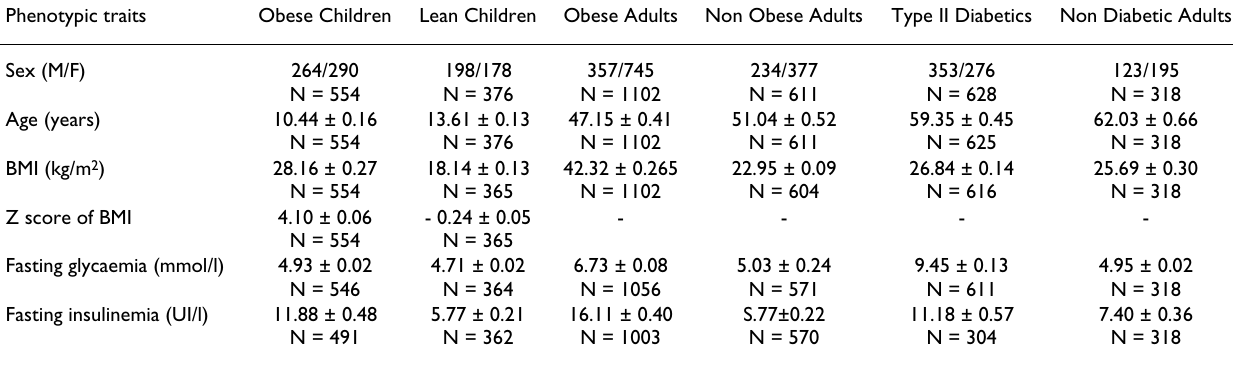
Table 1: Phenotypic characteristics of the studied populations.